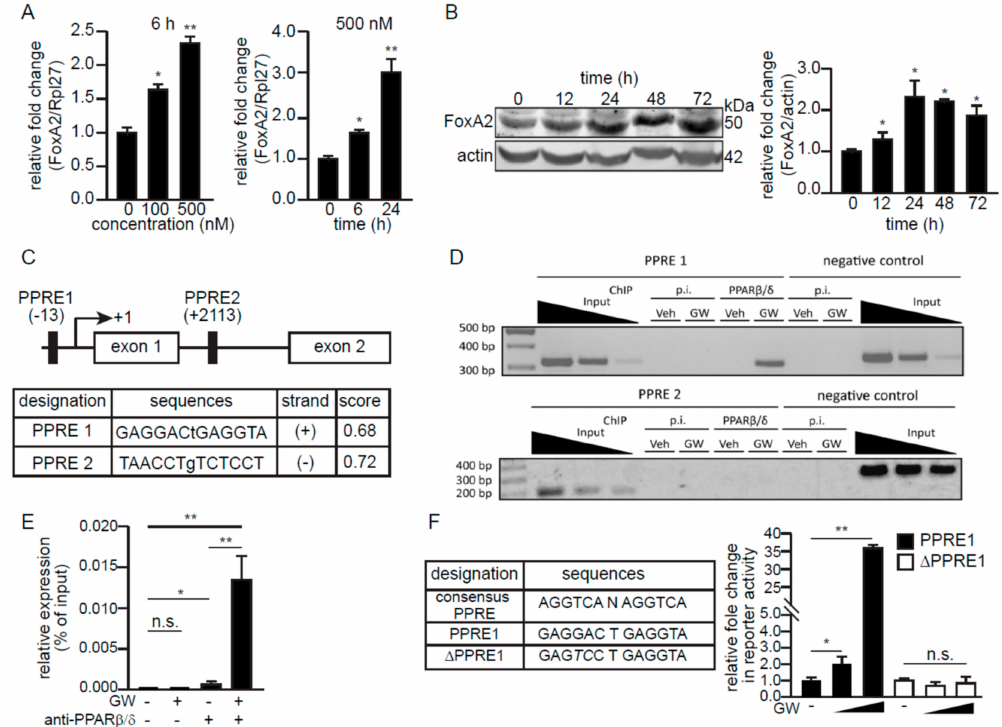
Figure 3. FoxA2 is a PPAR β / δ target gene in skeletal muscle. ( A , B ) Relative FoxA2 mRNA ( A ) and protein expression ( B ) in myotubes treated for the indicated time with indicated concentrations of GW501516 (GW). Representative immunoblots of FoxA2 are shown. Actin serves as a loading control from the same samples. Values are the mean + SD from 3 independent experiments. * p < 0.05; ** p < 0.01; and n.s., not significant; ( C ) A schematic diagram of putative PPREs in the promoter and the first intronic region of mouse FoxA2 gene. The below table shows the putative PPRE sequences and scores, with a maximum score of 1.0, which reflect the predicted confidence using NUBIScan, a prediction software for nuclear receptor response elements; ( D , E ) Chromatin immunoprecipitation (ChIP) of predicted PPREs in FoxA2 gene with PPAR β / δ antibody or pre-immune IgG (p.i.) in C2C12 treated with either vehicle (Veh) or GW ( D ). Quantitative ChIP-qPCR analysis of PPAR β / δ binding at PPRE1 in the presence or absence of GW treatment ( E ); ( F ) Relative luciferase activity from reporter gene constructs containing either PPRE1 or ∆ PPRE1 in HEK293T cells in the presence or absence of 1 and 10 µ M GW for 6 h. DMSO was used as the vehicle control. Values are the mean + SD from 3 independent experiments. * p < 0.05; ** p < 0.01; and n.s., not